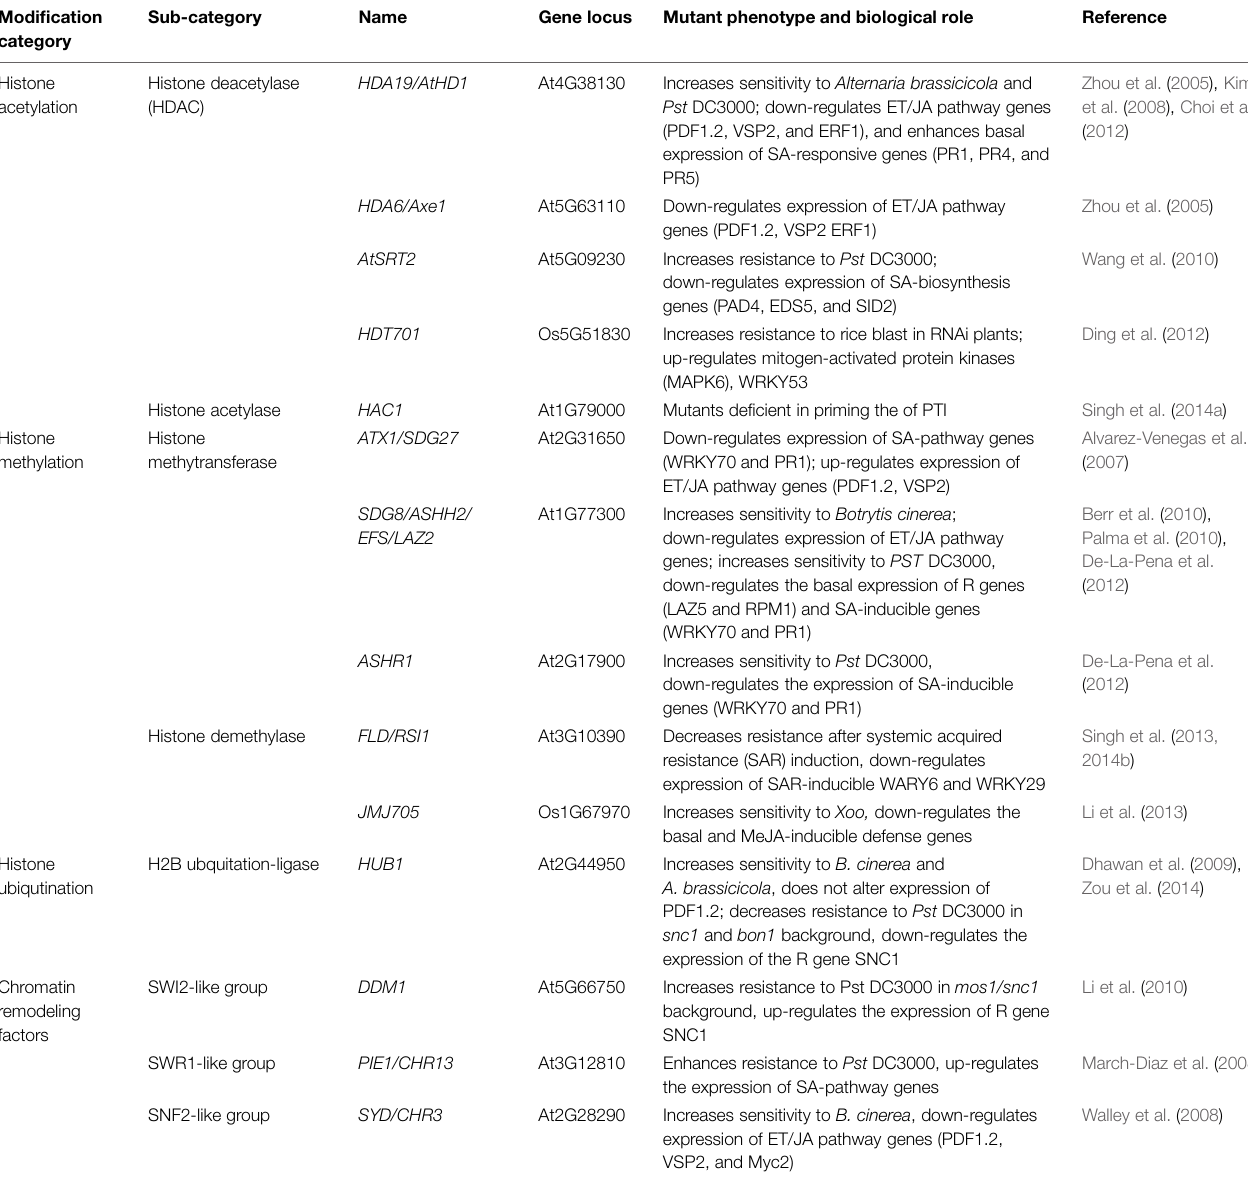
TABLE 1 | Histone-modifying enzymes and chromatin-remodelling factors involved in plant responses to